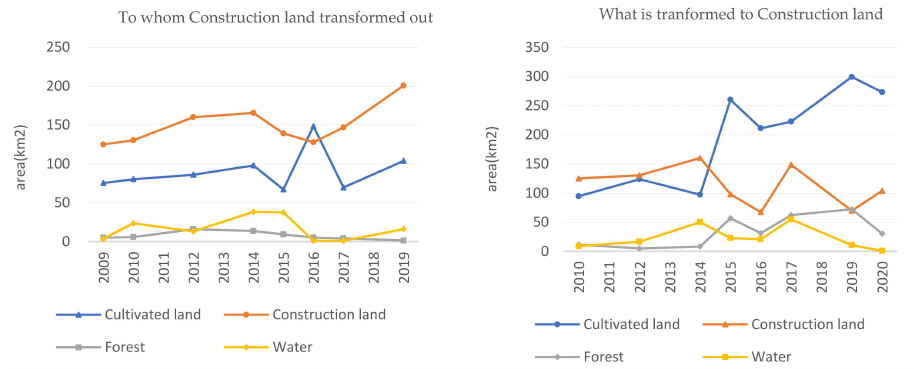
Figure 13. Changes of construction land in the studied area.